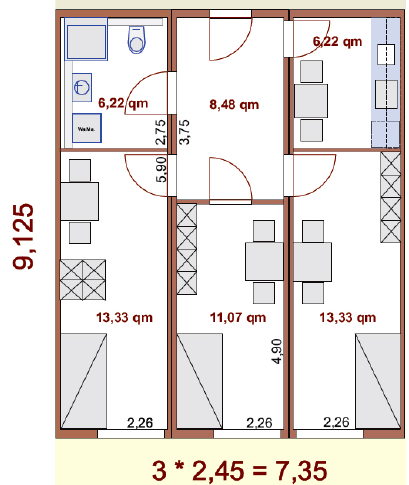
Figure 9. Floor plan of one apartment in a purpose-built, modular housing project for refugees. The apartments are designed for (up to) six people who share a bathroom, a kitchen and three bedrooms, furnished with bunk beds, a table, two chairs, and metal lockers. Source: Göttingen City website in